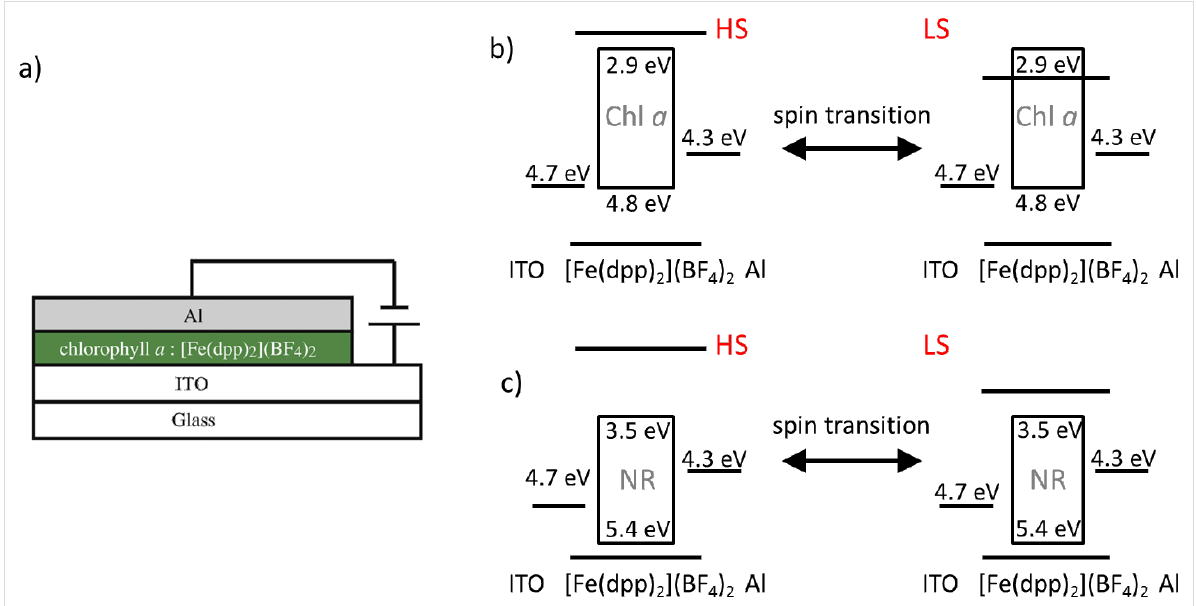
Figure 6: a) Architecture of the OLED device constructed by Matsuda et al. [28]. b) A schematic representation of the mechanism proposed for the EL, on/off switching, based on an energy level diagram of a device using Chl a and [Fe(dpp) 2 ](BF) 4 . c) Energy level diagram for an analog device but employing NR as the emitting material [30]. Adapted with permission from [28] and [30], copyright 2008 and 2013 Elsevier.